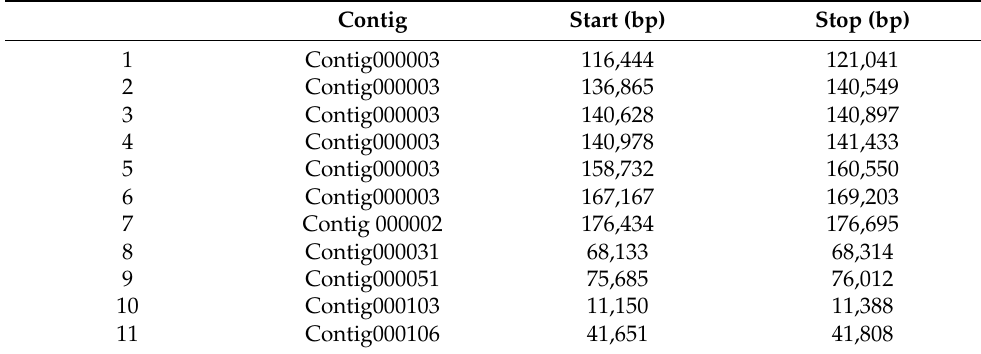
Figure A3. Dactylosporangium sp. AC04546 polyhydroxybutyrate metabolism subsystem based on KEGG pathway, predicted by RAST server, and viewed using The SEED Viewer. Color on the MAP corresponds to the predicted scenario in the legend below. Table A7. Dactylosporangium sp. AC04546 CRISPR array detected using CRISPRFinder server. Contig Start